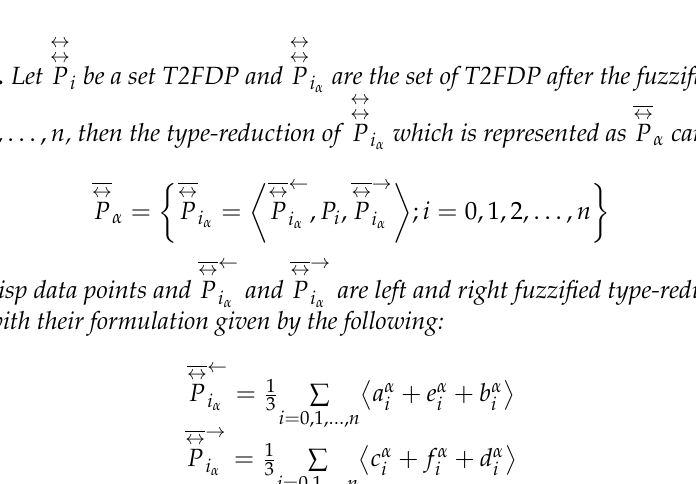
Figure 4. The illustration of the correlation between alpha values and T2FDPs.